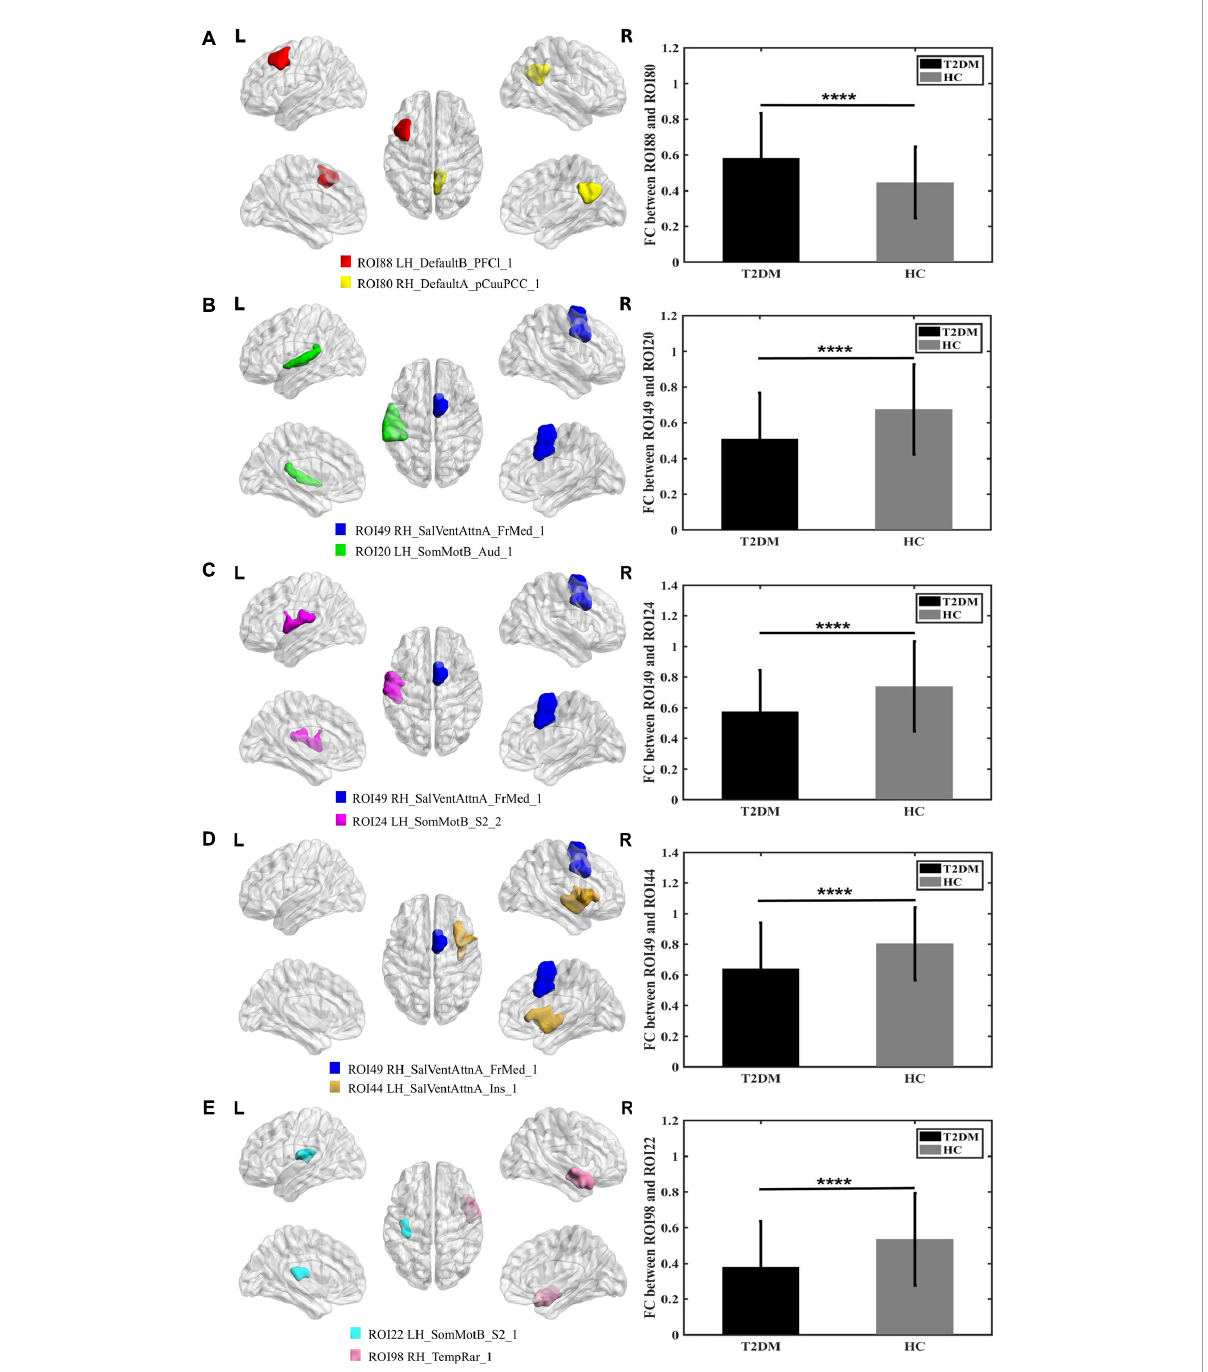
FIGURE1 Graphs show that significant difference in the functional connectivity between T2DM and HC (A–E) . (A) The colored brain regions represent significantly increased functional connectivity in T2DM compared with HC; (B–E) the colored brain regions represent significantly decreased functional connectivity in T2DM compared with HC. **** P ≤ 0.001.